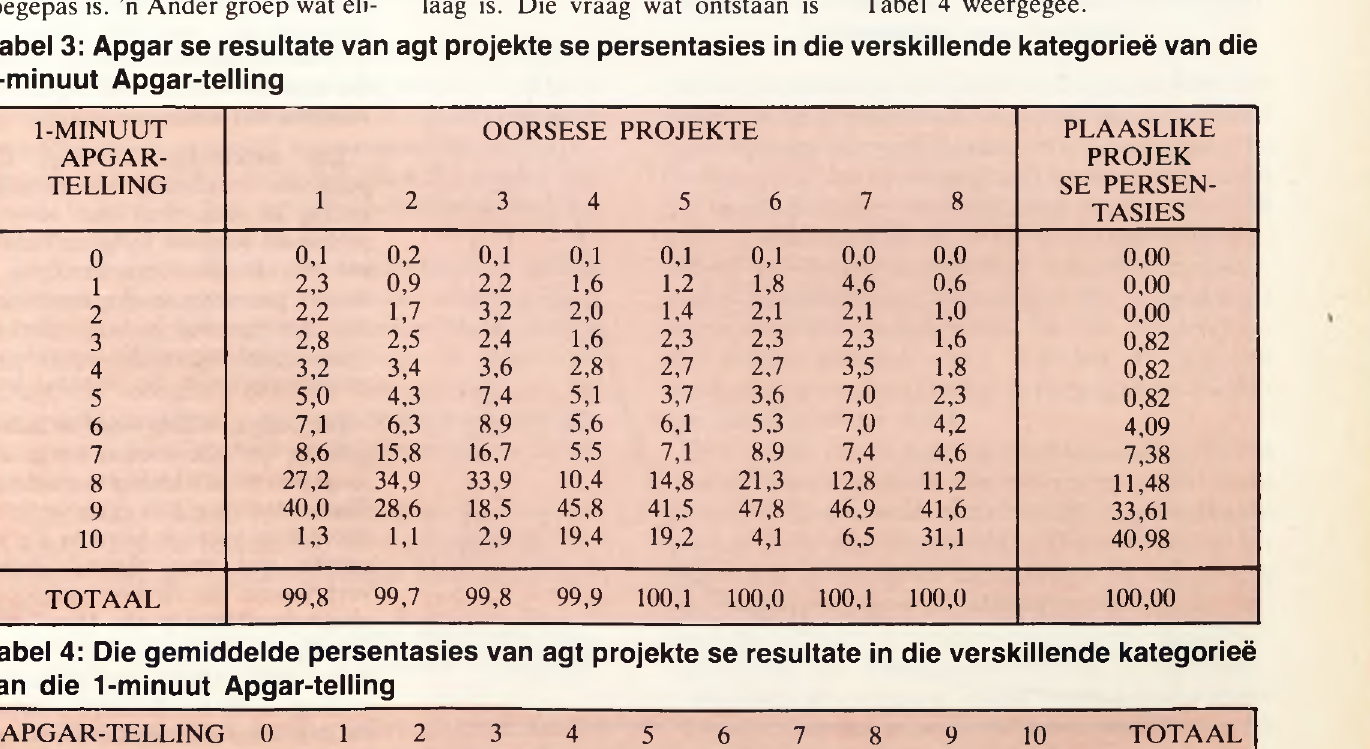
Tabel 3: Apgar se resultate van agt projekte se persentasies in die verskillende kategorieë van die 1-minuut Apgar-telling